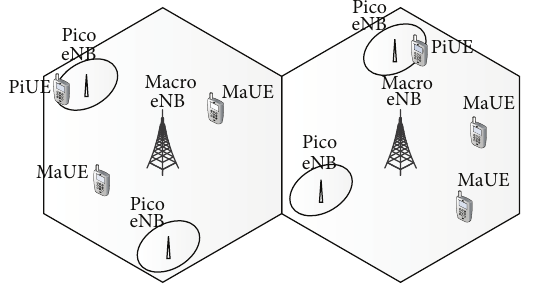
Figure 1: The heterogeneous